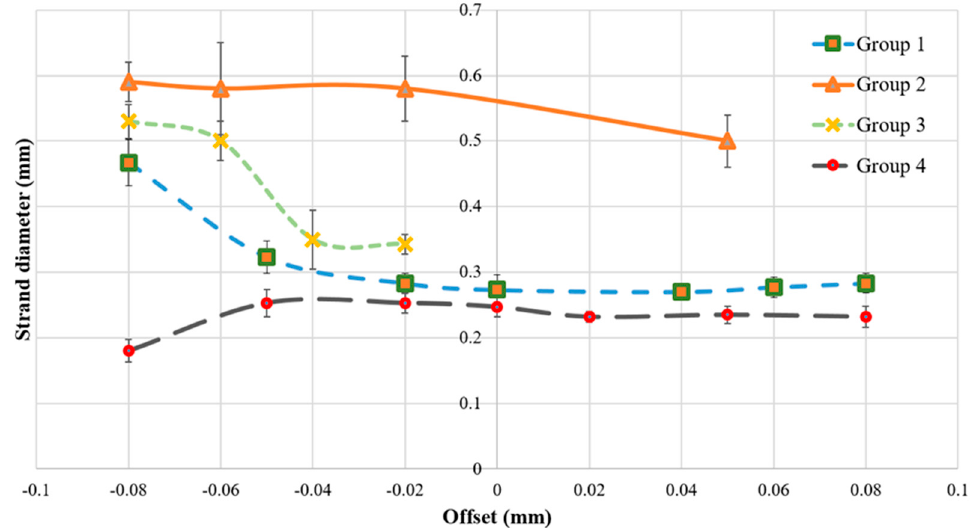
Figure 7. E ff ect of o ff set on the strand diameter of sca ff olds made of Groups 1 to Figure 7. Effect of offset on the strand diameter of scaffolds made of Groups 1 to 4.